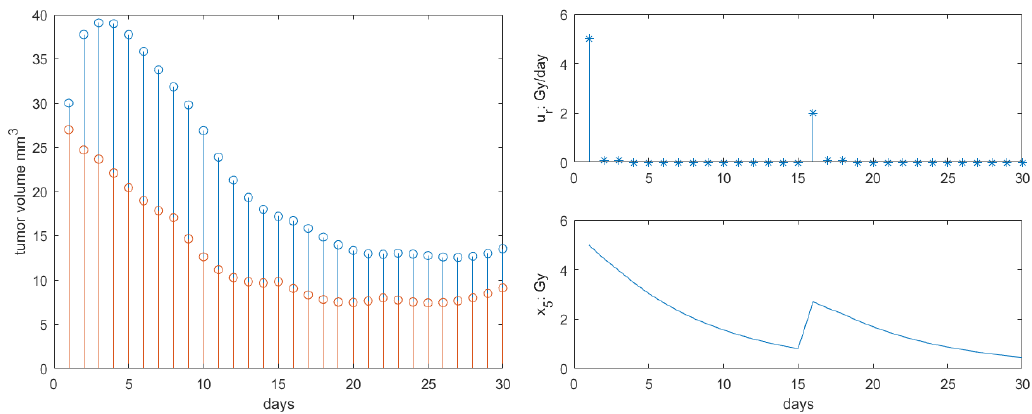
Figure 6. Results obtained for Protocol 3. Left : total tumor growth (blue stems) and necrotic tumor volume (red stems) response to therapy. Right : radiotherapy profile along with concentration profiles in